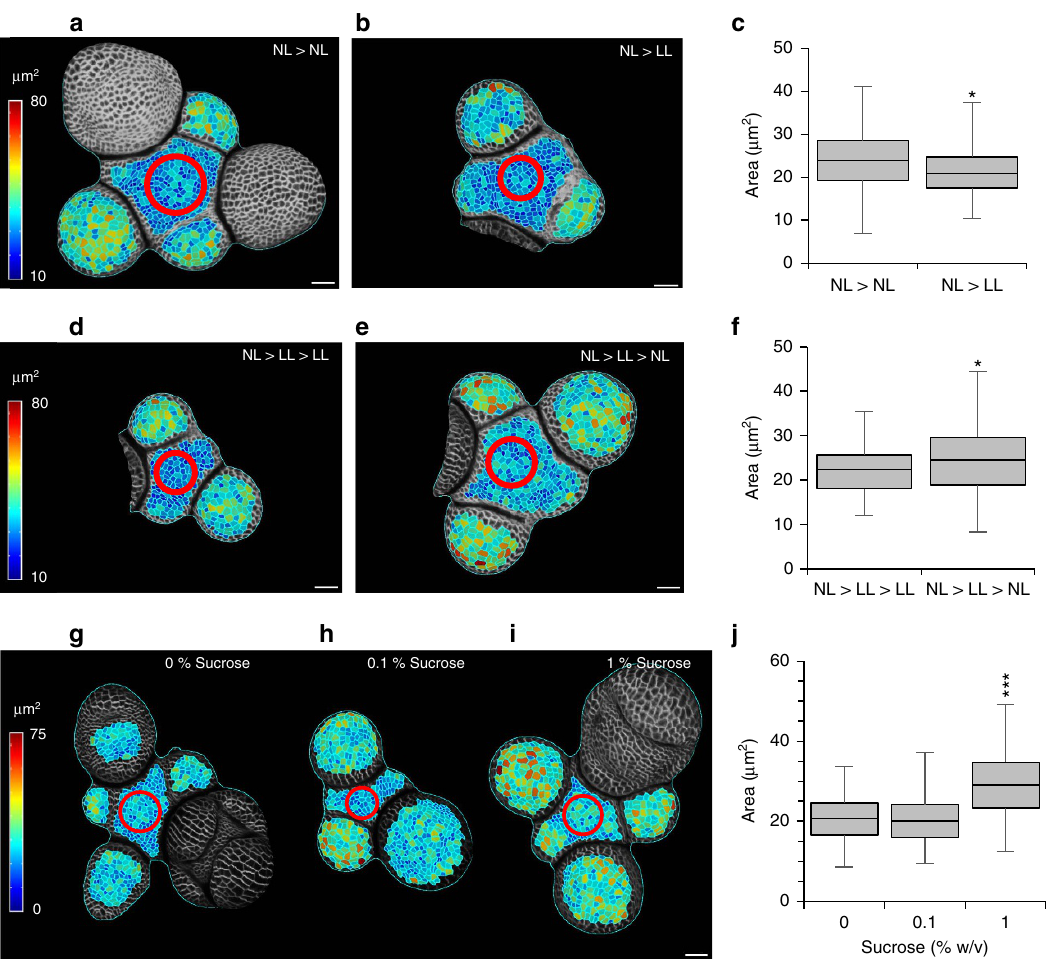
Figure 3 | Mean cell size in the SAM is dynamic and dependent on metabolic constraints. ( a , b ) Segmented surface projections of stems from plants grown to floral transition under normal light intensity (NL) then either kept under NL conditions ( a ) or transferred to low light intensity (LL) conditions ( b ). Shading indicates outer cell surface area. Red circle indicates the region between outgrowing primordia used for quantification. Scale bars represent 20 m m. ( c ) Distribution of cell sizes under NL 4 NL and NL 4 LL. Boxes represent the interquartile range, whiskers represent total range. (Generalized Linear Mixed Model (GLMM), n ¼ 348 cells from 12 stems, 6 stems per treatment). ( d , e ) Segmented surface projections of stems grown under NL 4 LL conditions then kept in LL ( d ) or transferred back to NL ( e ). Shading indicates the outer cell surface area. Red circle indicates the region between outgrowing primordia used for quantification. Scale bars represent 20 m m. ( f ) Distribution of cell sizes under NL 4 LL 4 LL and NL 4 LL 4 NL conditions. Boxes represent the interquartile range, whiskers represent total range. (GLMM, n ¼ 321 cells from 10 stems, 5 stems per treatment). ( g – i ) Segmented surface projections of dissected stems from plants grown under NL 4 LL conditions, then cultured for 72h growth on media containing 0% ( g ), 0.1% ( h ) or 1% sucrose ( i ). Shading indicates the outer cell surface area. Red circle indicates the region between outgrowing primordia used for quantification. ( j ) Distribution of cell sizes following 72h growth on medium containing 0, 0.1 or 1% sucrose. Boxes represent the interquartile range, whiskers represent total range. (GLMM, n ¼ 483 cells from 12 stems, 3 stems per treatment). *, **, *** indicate a significance at the 0.05, 0.01 and 0.001 levels relationship between birth size and cycle length and (iv) predict division size proportional to g . We first ran the model without variation in g or d and without any interaction between cell size and pCDK or T Division . In this case, if neither pCDK nor T Division are dependent on cell size, cell-cycle length is invariant, consistent with a ‘timer’ mechanism 1 . In this case cell size at division is only constant when cell cycle length is equal to the time taken for the cell to double in size. Cell size does not converge following a simulated uneven division (Fig. 4b) and changing the RGR ( g ) leads to unstable division sizes (Fig. 4c). If experimentally observed variations in RGR and division ratio within a population are included in g and d , the distribution of cell sizes degrades over time, leading to an increasingly broad distribution of cell sizes (Fig. 4d). The model demonstrates that a timer mechanism based on the parameters measured from our experiments would not be sufficient to produce constant cell size.